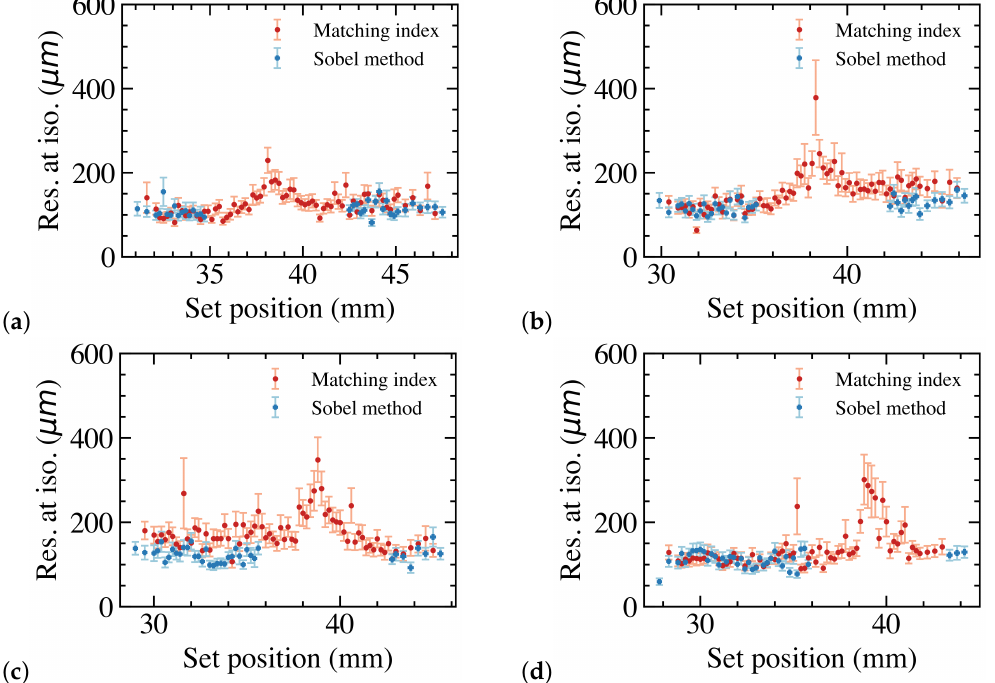
Figure 5. Reconstructed MLC leaf edge position as a function of the set leaf position for leaf 1. The transition between Lassena 2 and Lassena 1 is at a set position of 38.364 mm ( a ). Leaf position residual as a function of the set position for leaf 1. The transition between Lassena 2 and Lassena 1 is at a set position of 38.364 mm ( b ). Residual distribution for leaf 1. A Gaussian fit yields a resolution of 89 ± 9 µ m ( c ). Resolution as measured over the entire range as a function of the MLC number ( d